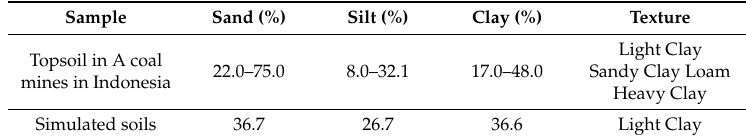
Table 1. Soil texture of topsoil in A coal mine in Indonesia and the simulated soils